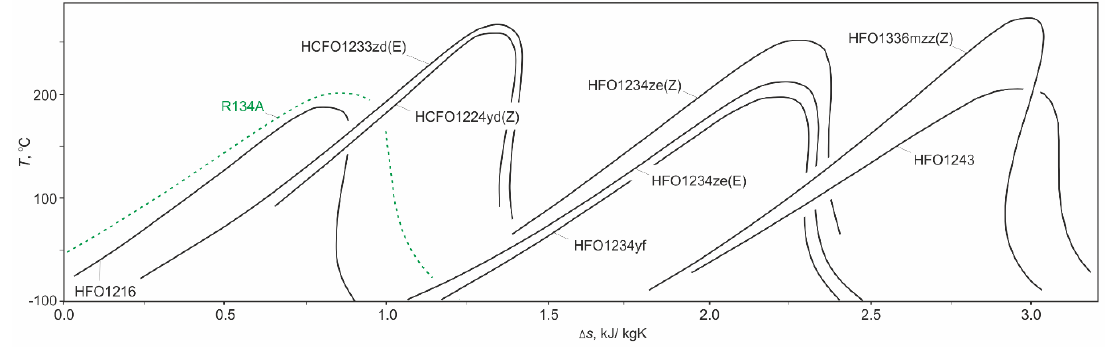
Figure 6 . Comparison of the saturation curves of HFO/HCFO refrigerants shown in a T – s graph. Figure 6. Comparison of the saturation curves of HFO/HCFO refrigerants shown in a T – s